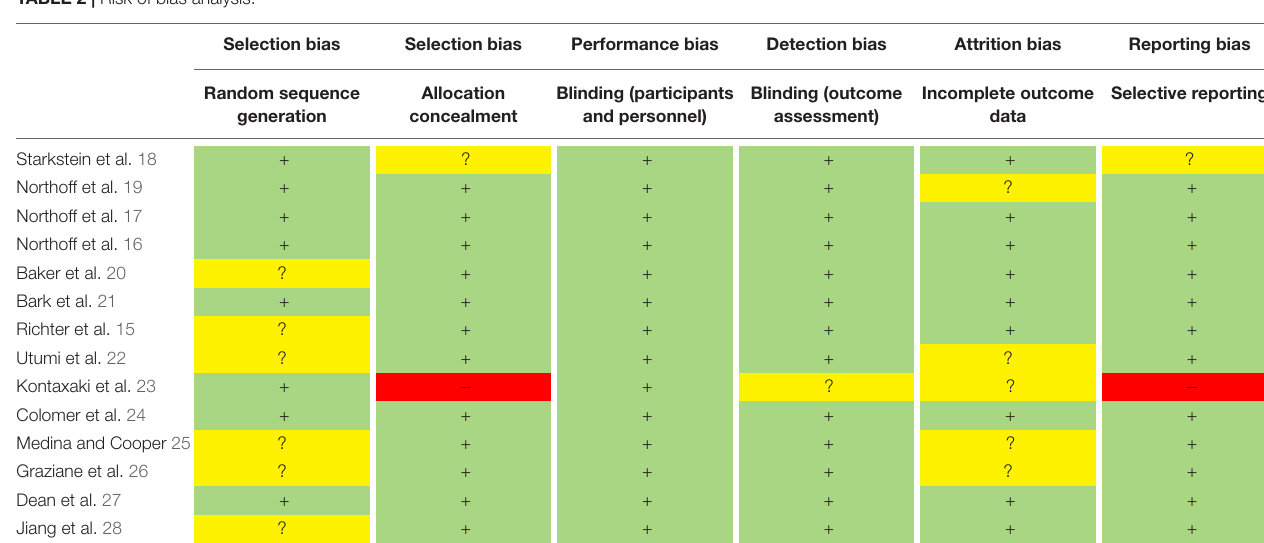
TABLE 2 | Risk of bias